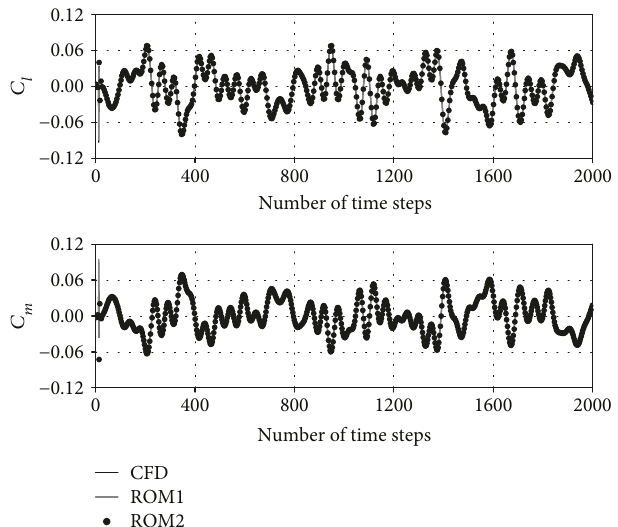
α = 5 deg (ROM1-training data via CFD; ROM2-training ∞ = 0 82 and 0